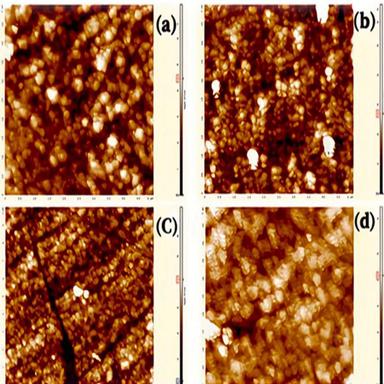
AFM micrograph of (a) pure (b) 1 wt% (c) 2.5 wt% and (d) 5 wt% Ce doped NiO films.